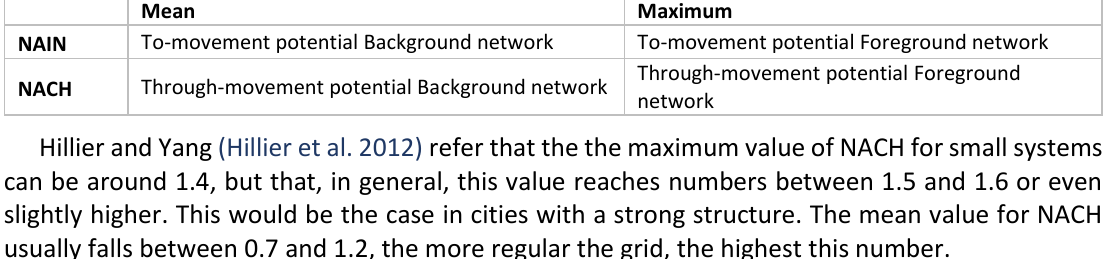
Table 1 NACH and NAIN variables and their meaning Mean